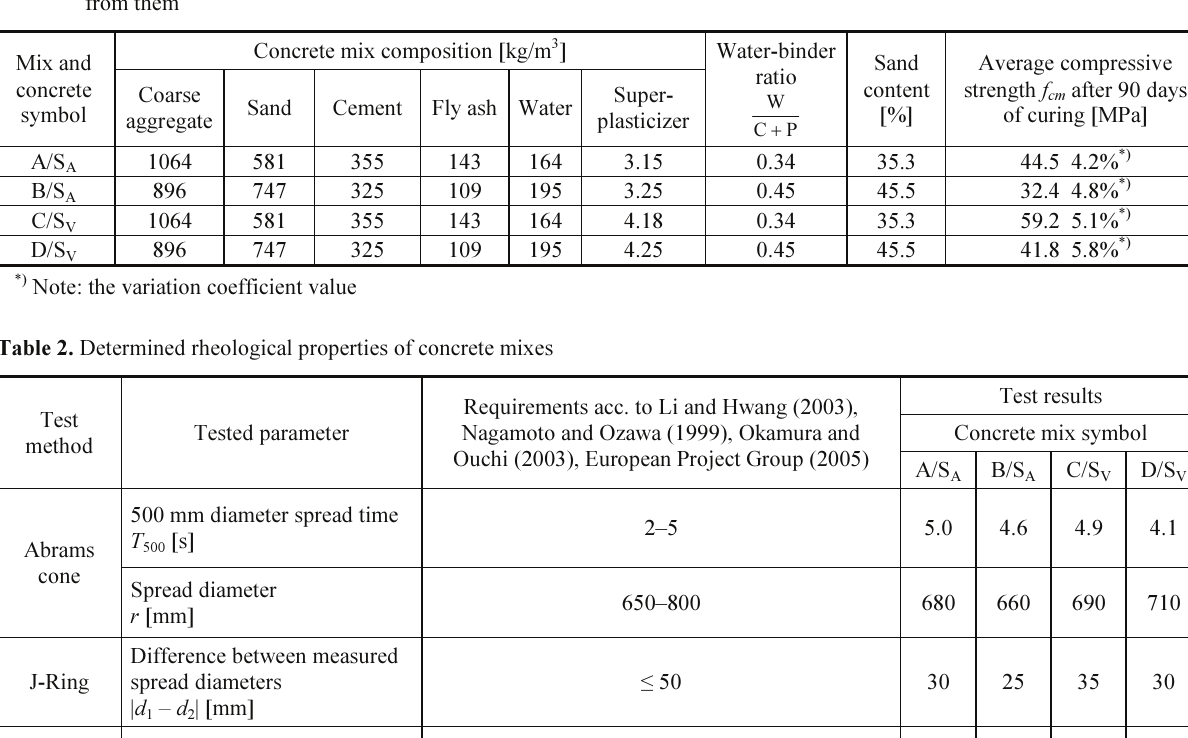
Table 1. Compositions of designed self-compacting concrete mixes and average compressive strengths f cm of concretes produced